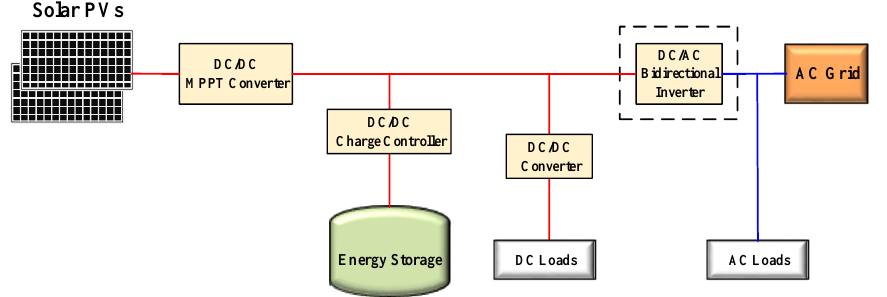
Figure 1. Schematic configuration of DC distribution systems integrated with a grid and a backup system.